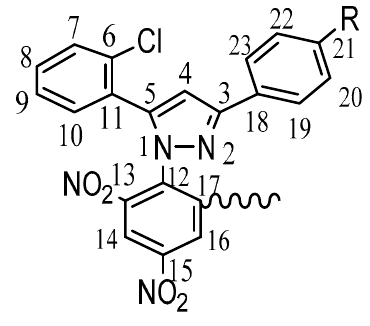
Figure 1. General structure formula.